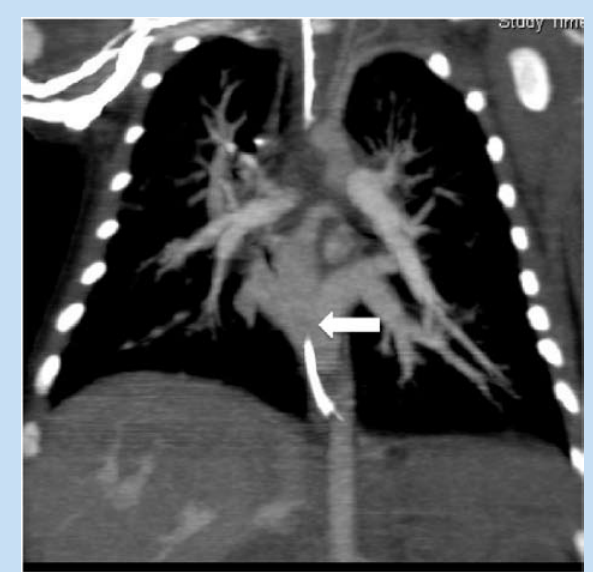
hiatus.Fig. 2a. MIP reconstruction of the CT angiogram showing the four pul- monary veins converging to form a common channel (arrow) rather than entering the left